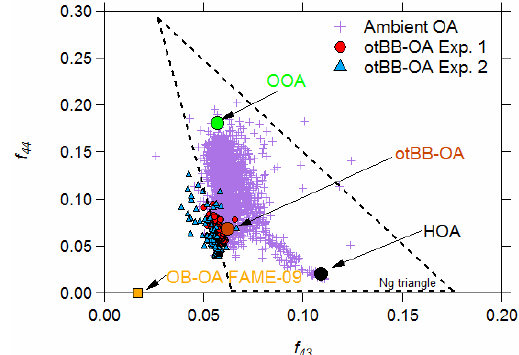
Figure 11. Ambient and chamber OA data in the Ng et al. (2010) triangle. The ambient Fig. 11. Ambient and chamber OA data in the Ng et al. (2010) trian- OA falls within the triangle. The chamber otBB-OA and the otBB-OA PMF solution are near the bottom left side of the triangle. gle. The ambient OA falls within the triangle. The chamber otBB- OA and the otBB-OA PMF solution are near the bottom left side of the